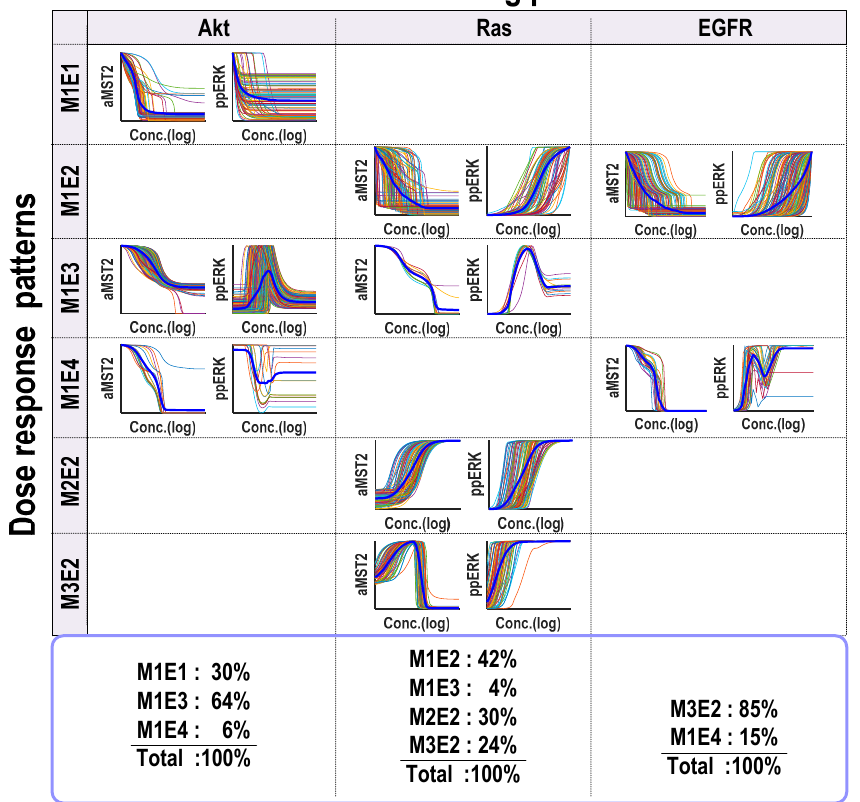
Figure 4. Clustering the dose ‐ response profiles into four dynamic patterns. Combining two network outputs (active MST2 and ERK), the Hippo ‐ ERK network generates a total of eight different patterns for the three controlling proteins (Akt, Ras and EGFR). The x ‐ axis of each subplot is the log concentration of a controlling protein and the y ‐ axis is the normalized activity of aMST (ppERK) by its maximum.